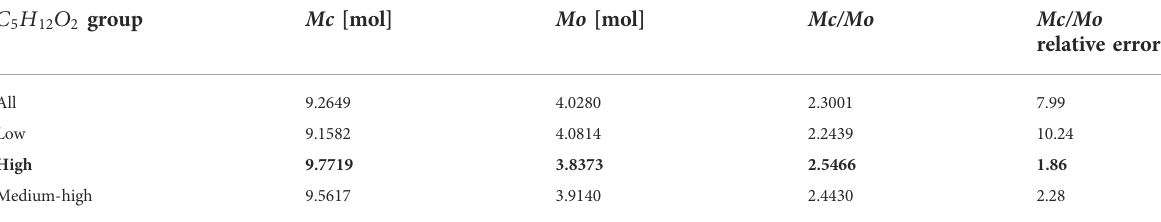
TABLE 6 Numeric solution of pentanediol.